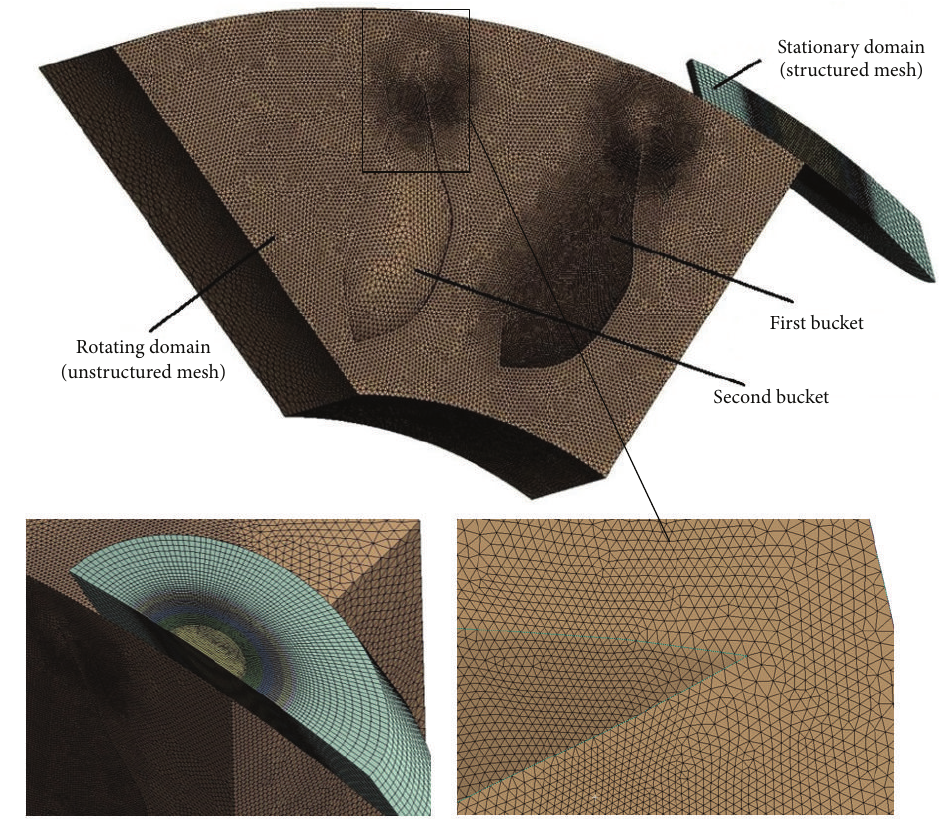
Figure 6: Computational domain and structure of the 3D mesh.